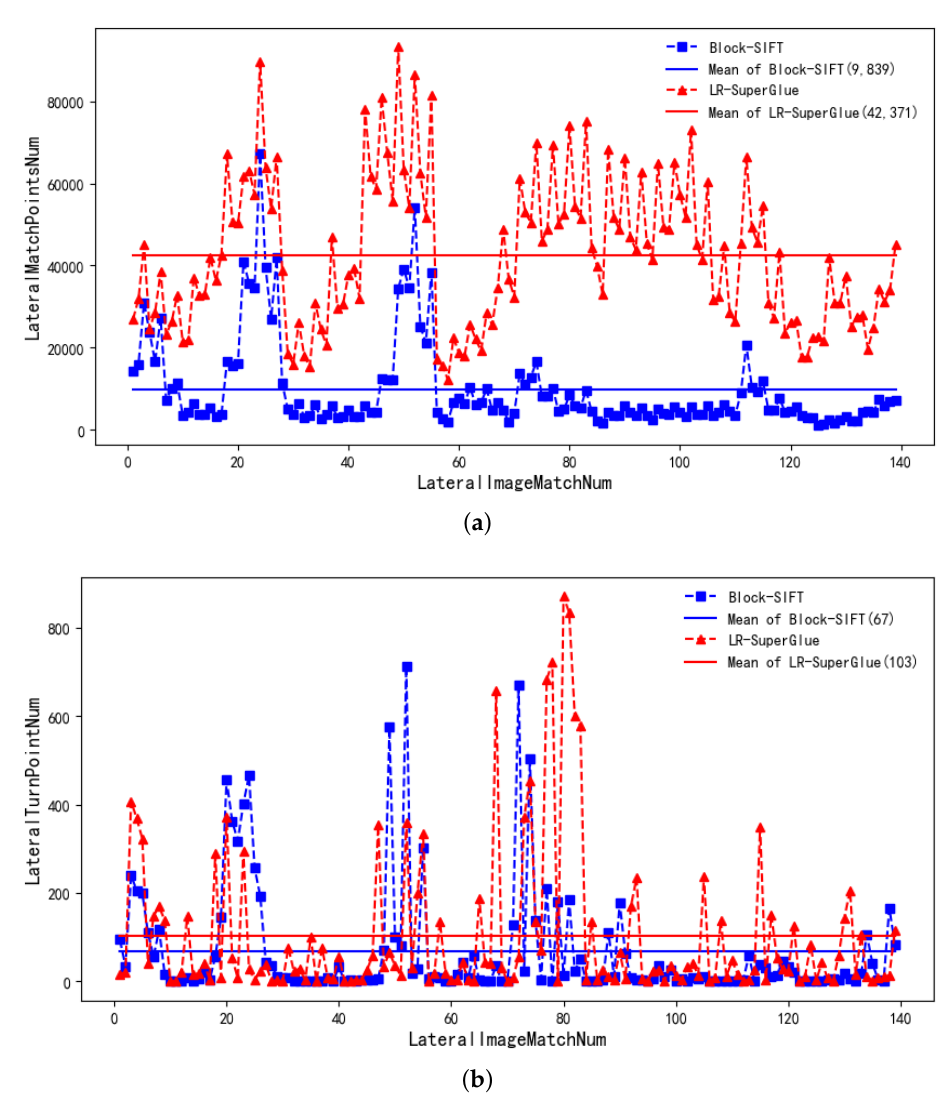
Figure 13. Lateral image matching and tie points number. ( a ) Lateral image matching points number; ( b ) Lateral image turning points